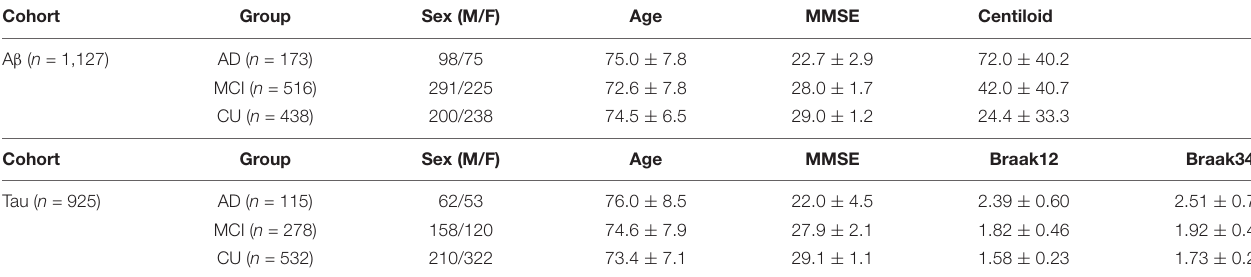
TABLE 1 | Demographic information for the participants we studied from the ADNI.